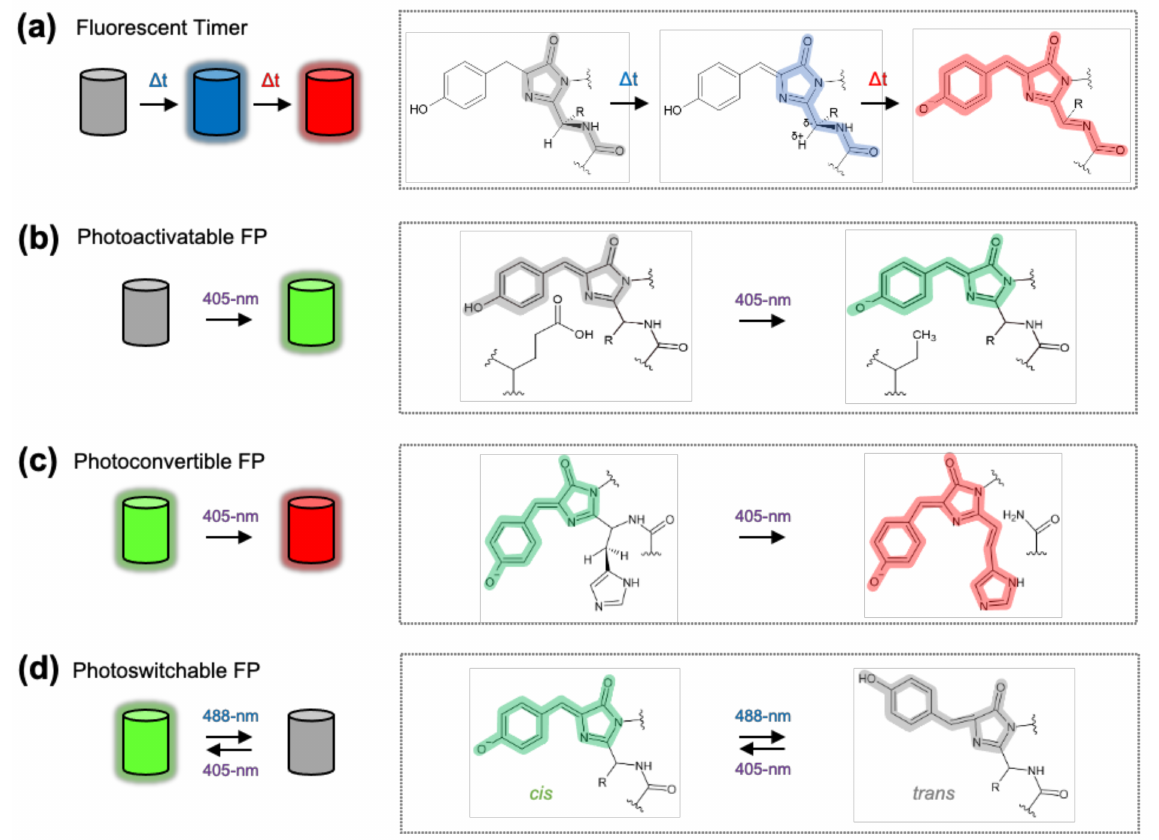
Figure 3. Mechanism of fluorescent timer, photoactivation, photoconversion and photoswitching. ( a ) Scheme of monomeric fluorescent timer (FT) and its chromophore structure (box). Slow maturation process (oxidation) of chromophore of FT allows the alteration of emission wavelength alteration over time. ( b ) Scheme of photoactivatable GFP (PA-GFP) and its chromophore structure (box). Illumination of 405-nm light induces the decarboxylation of the key residue near the chromophore of PA-GFP, transforming the chromophore to be a fluorescent emitting form. ( c ) Scheme of photoconvertible FP (EosFP) and its chromophore structure (box). Illumination of 405-nm light induces the cleavage of peptide backbone near chromophore, changing the color of emitting fluorescence from green to red. ( d ) Scheme of photoswitchable FP (Dronpa) and its chromophore structure (box). Illumination of 488-nm light induces cis-to-trans isomerization of chromophore turning off the fluorescence, while 405-nm light reverses it by trans-to-cis isomerization turning on the fluorescence. Highlighting blue, green, red colors on the chromophores display the color of emitting fluorescence, and gray represent non-fluorescent state of